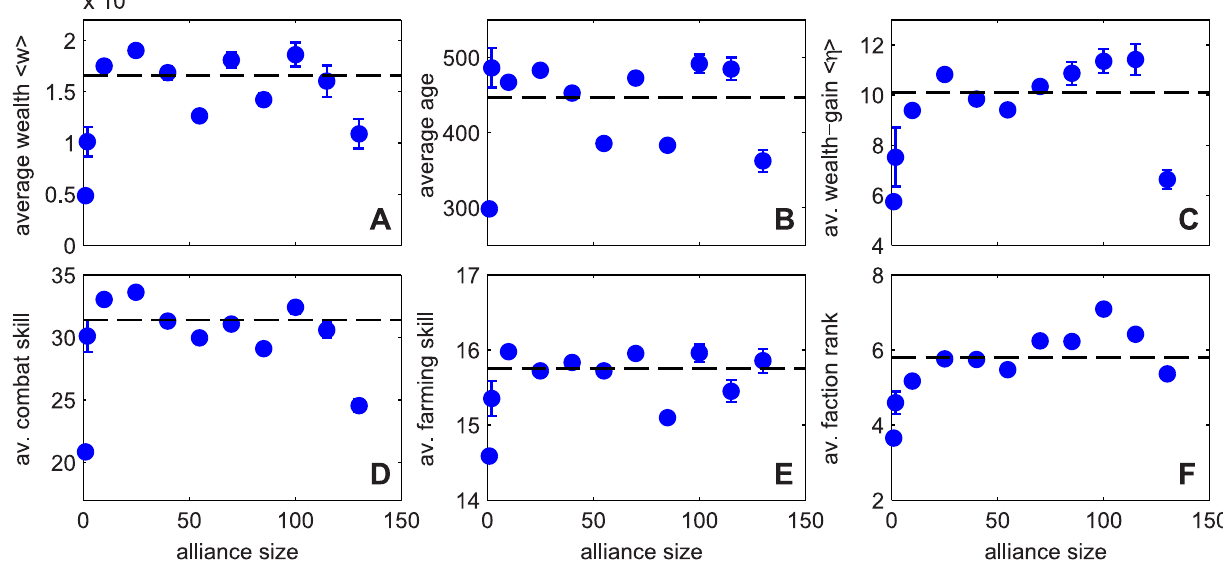
Figure 7. Wealth and other properties as a function of alliance size. We bin players according to the size of the alliance they belong to, and show various properties as a function of alliance size: A wealth, B age, C wealth-gain, D combat skill, E farming skill, F faction rank. First bin are players in no alliance, second bin are players in an alliance of size two. Clearly members of these smallest alliances show low wealth and achievement measures. Also for the largest groups, lower levels are observable. Error bars denote the standard errors of these means (assuming Gaussian distributions). The black dashed line shows the average over all players in an alliance with at least three members. Data are taken every 240 days (see Methods). doi:10.1371/journal.pone.0103503.g007 PLOS ONE |